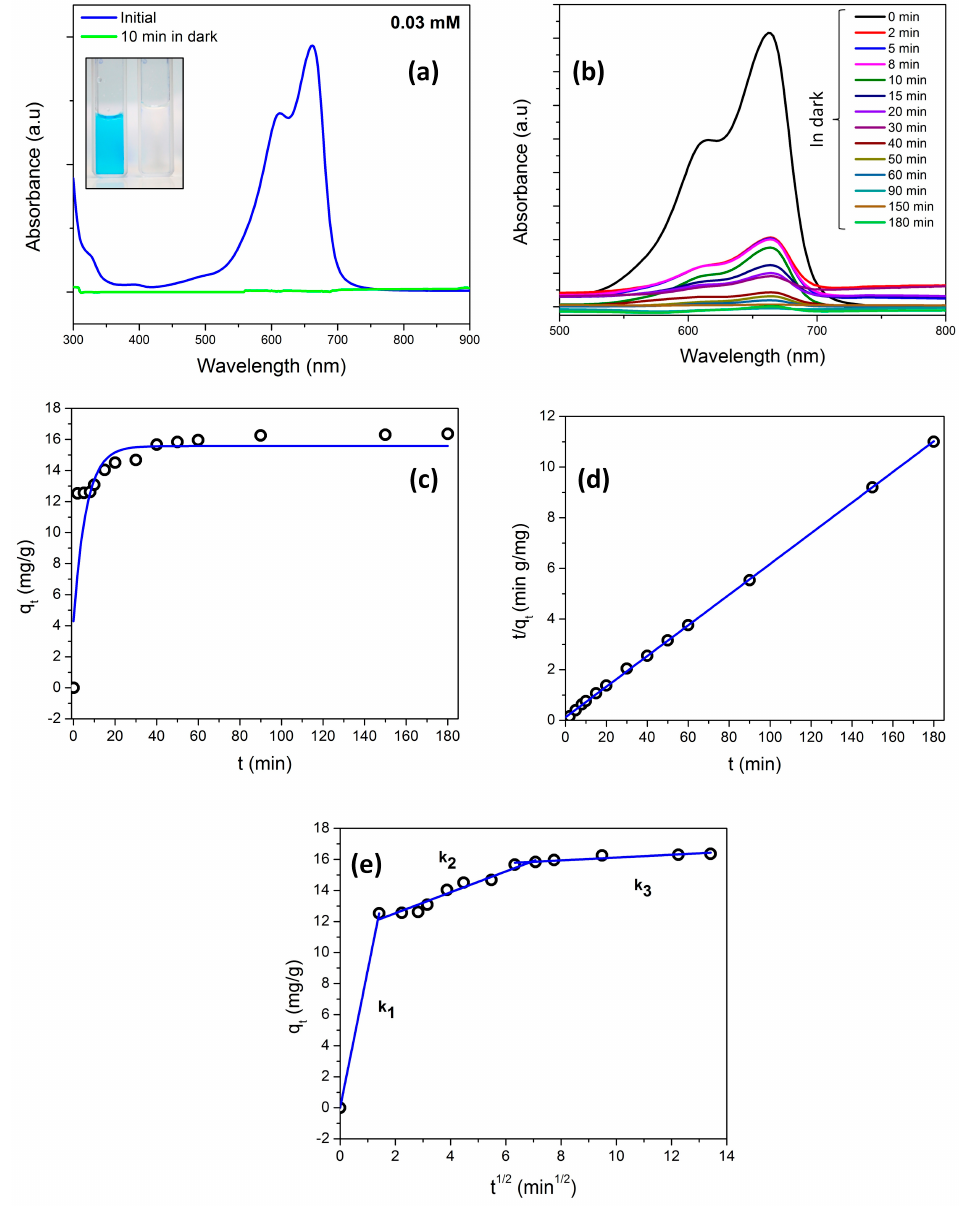
Figure 10. ( a ) UV-vis absorption spectra for 0.03 mM MB with 50 mg of mesoporous nanocomposite; inset: photograph revealing the decolorization of MB; ( b ) UV-vis absorption spectra for 0.03 mM MB with 25 mg of mesoporous nanocomposite; ( c ) pseudo first-order kinetics model; ( d ) pseudo second-order kinetics model; ( e ) intra particle-diffusion kinetic model.